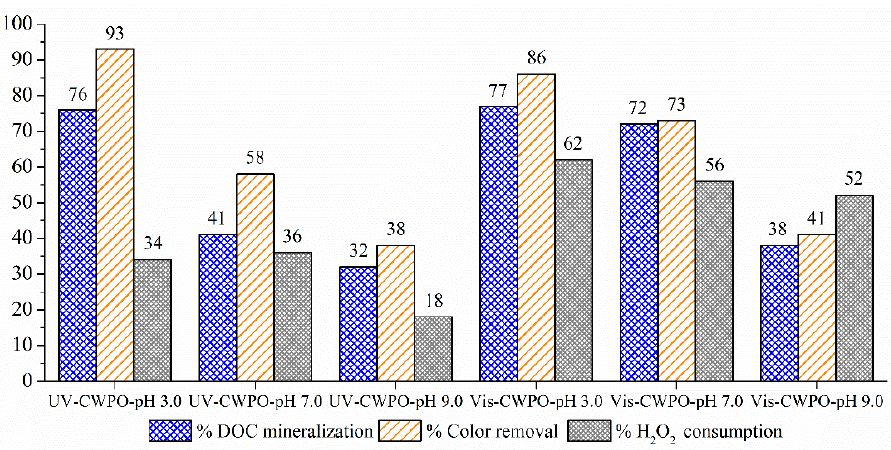
Figure 6. UV- and visible-light assisted photo-CWPO at three different initial pH values (3.0, 7.0 and 9.0). UV light source λ = 365 nm; Visible light source: steepest wavelengths at 450 and 550 nm; [DOC] 0 : 7.0 mg C/dm 3 ; H 2 O 2 dose: 3.77 mg H 2 O 2 /mg C (30 mg/dm 3 ); [Al/Fe-PILC]: 3.81 g/dm 3 ; T: 20.0 ± 1.0 ◦ C; atmospheric pressure: 100 kPa. Fe leaching < 0.1 mg/dm 3 .